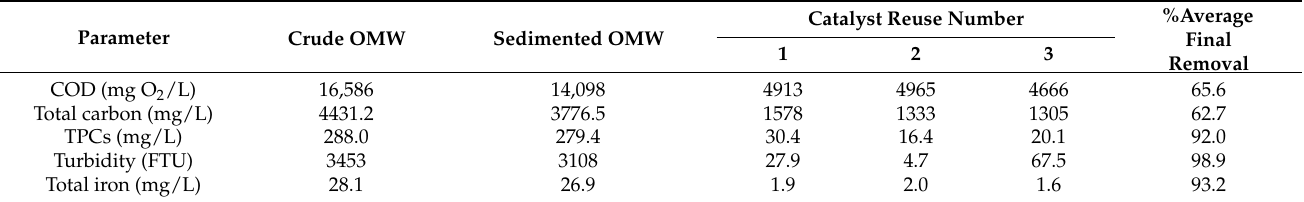
Table 4. Final values of main characterization parameters after natural OMW sedimentation (sedimented OMW) and photo-Fenton-like treatment in different rounds, reusing the heterogeneous HFeO 2